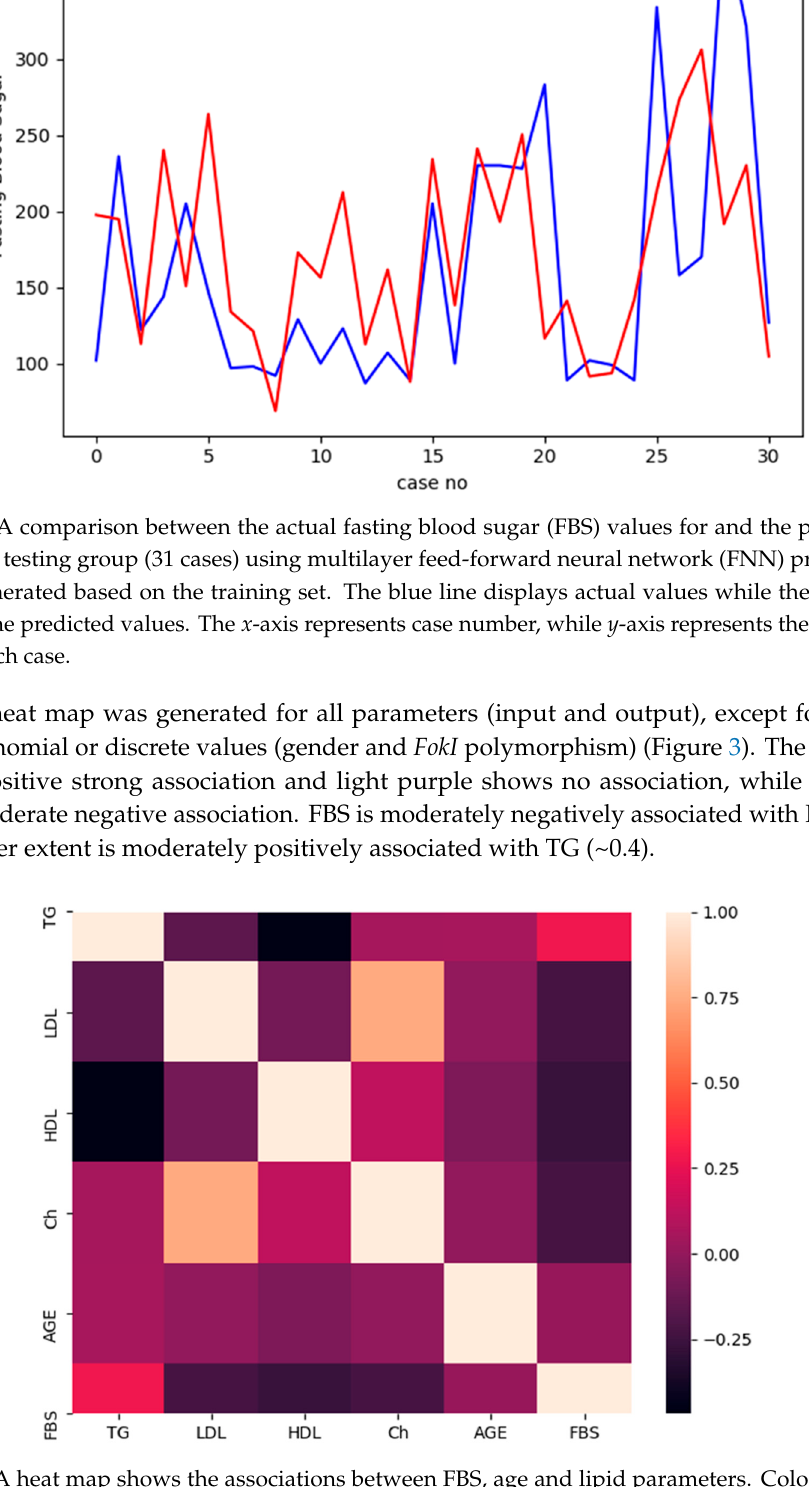
Figure 3. A heat map shows the associations between FBS, age and lipid parameters. Color scale is displayed at the right corner. Light colors (i.e., yellow) indicate a positive correlation, while dark colors (i.e., dark purple) indicate a negative association. FBS is moderately negatively associated with HDL, while to a lesser extent is moderately positively associated with TG.